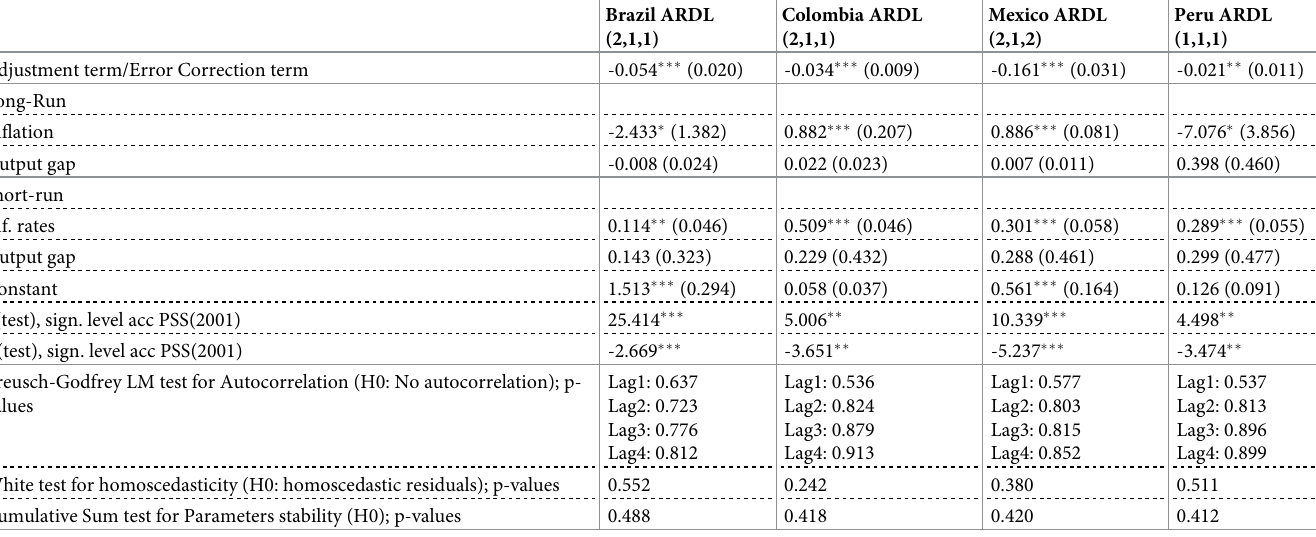
Table 4. ARDL results for the relation between national interest rates and inflation and output